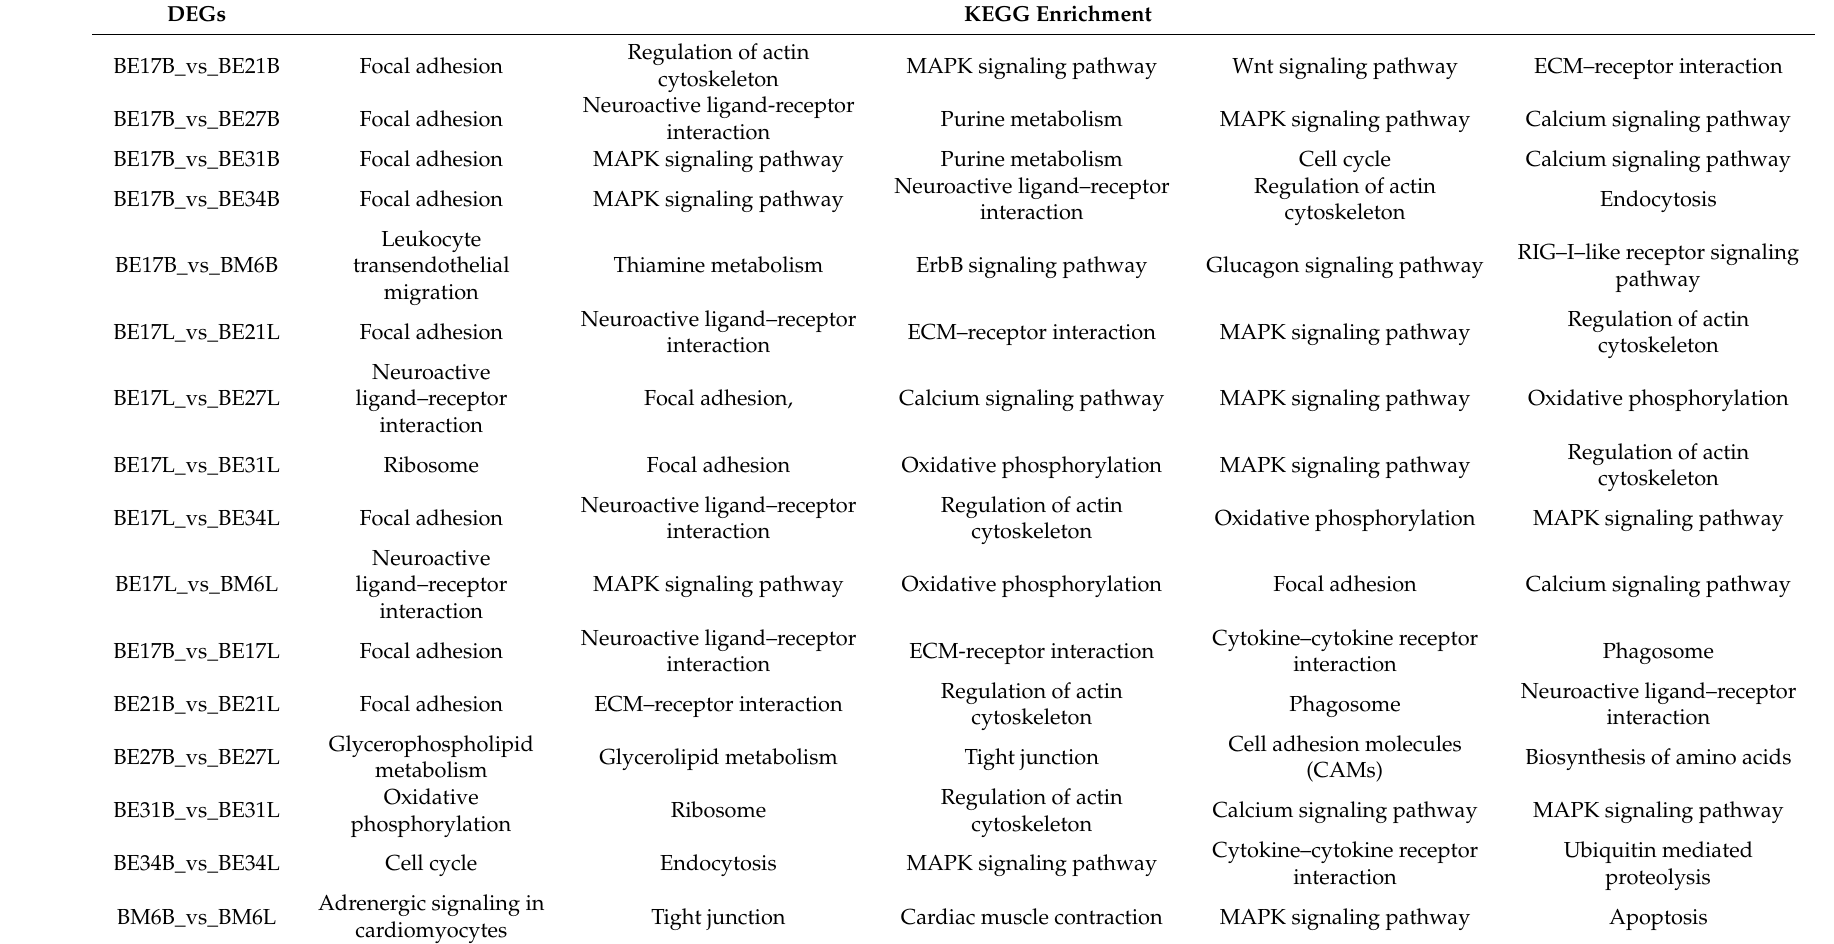
Table 7. Top 5 of KEGG